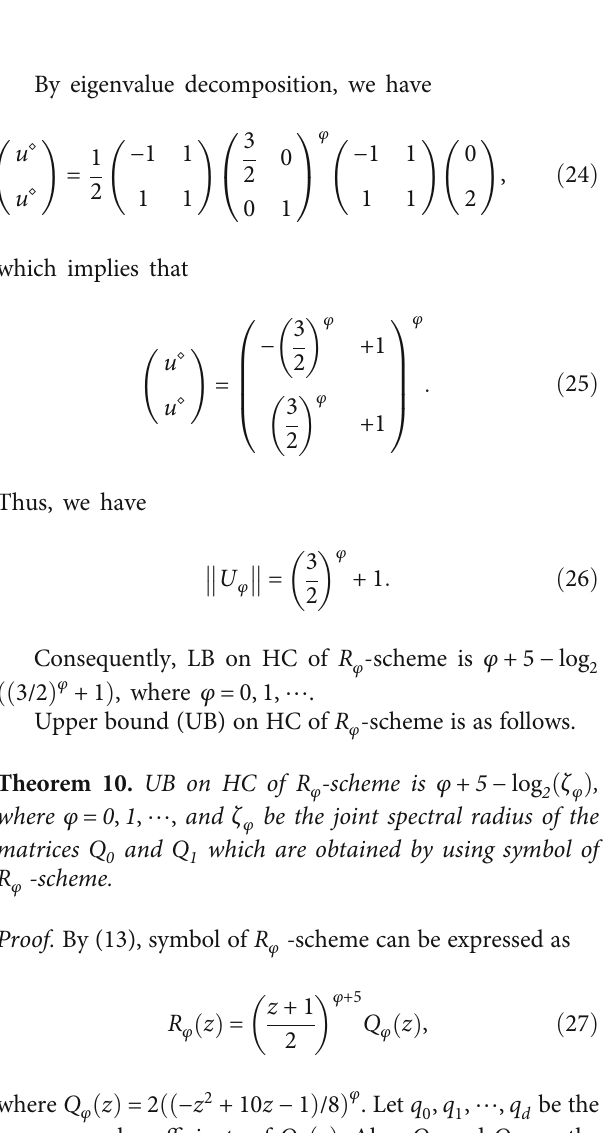
Figure 1: (a, b) Basic limit functions generated by the proposed schemes R